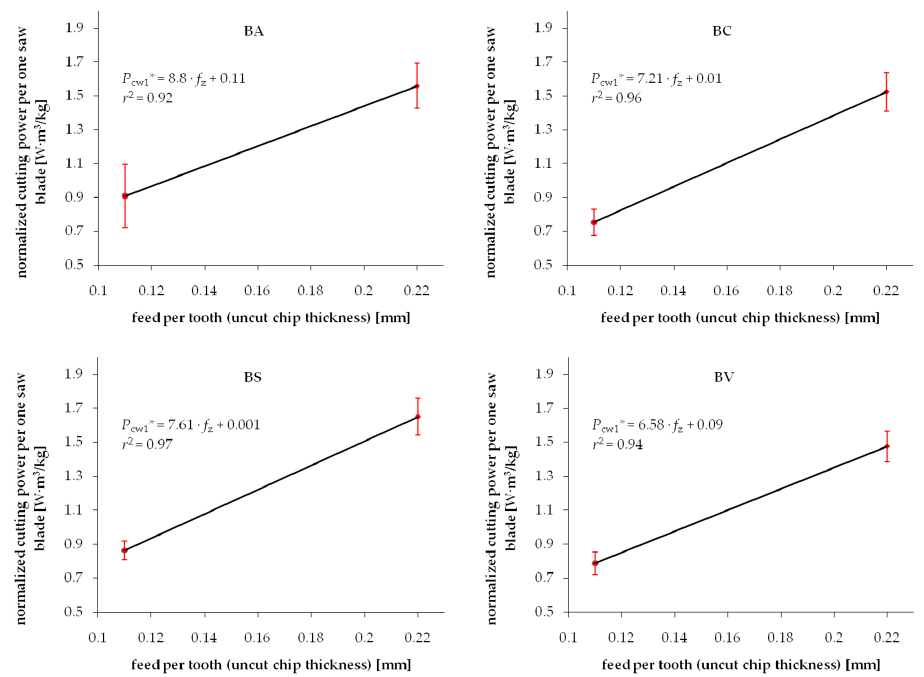
Figure 6. Relation between normalized (by density) cutting power per one saw blade and uncut chip Figure 6.